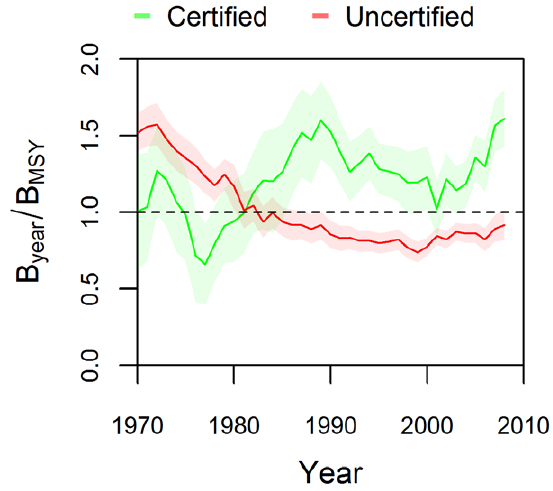
Table S4 Median biomass and exploitation rates relative to their targets and differences among certified, uncertified and not-